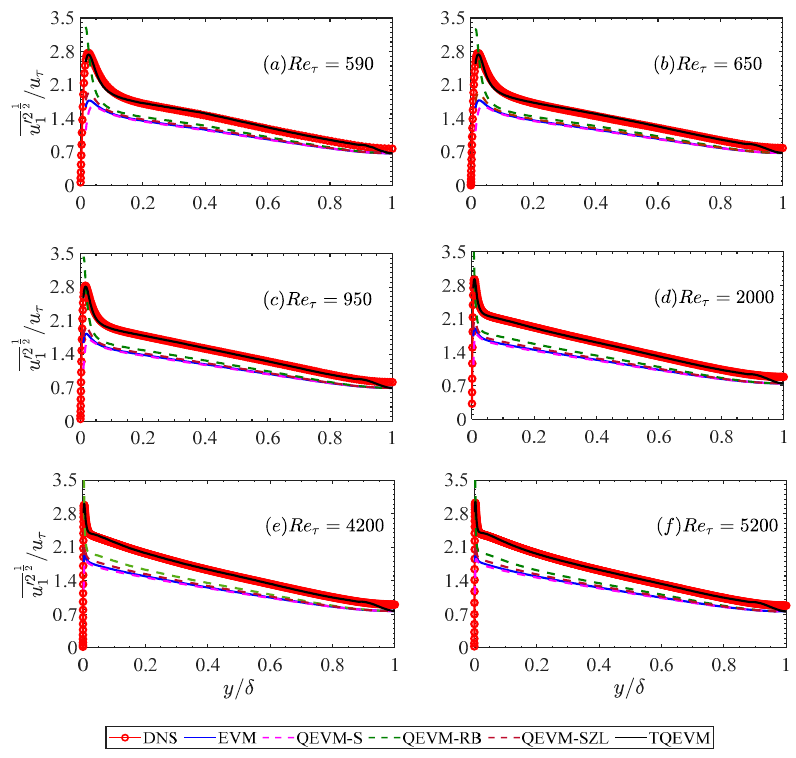
11/2 Figure 6. Dimensionless normal Reynolds stress (cid:1873) (cid:4593) (cid:2869)(cid:2870) (cid:3364)(cid:3364)(cid:3364)(cid:3364) (cid:2869) (cid:2870)⁄ (cid:1873) (cid:3099) (cid:3415) as a function of dimensionless wall distance (cid:1877) (cid:2012)⁄ Figure 6. Dimensionless normal Reynolds stress u (cid:48) 2 / u τ as a function of dimensionless wall distance for ( a ) (cid:1844)(cid:1857) (cid:3099) = 590 , ( b ) (cid:1844)(cid:1857) (cid:3099) = 650 , ( c ) (cid:1844)(cid:1857) (cid:3099) = 950 , ( d ) (cid:1844)(cid:1857) (cid:3099) = 2000 , ( e ) (cid:1844)(cid:1857) (cid:3099) = 4200 , and ( f ) (cid:1844)(cid:1857) (cid:3099) = 5200 Figure 6. Dimensionless normal Reynolds stress (cid:1873) (cid:4593) (cid:2869)(cid:2870) (cid:3364)(cid:3364)(cid:3364)(cid:3364) (cid:2869) (cid:2870)⁄ (cid:1873) (cid:3099) (cid:3415) as a function of dimensionless wall distance (cid:1877) (cid:2012)⁄ y / δ for ( a ) Re τ = 590, ( b ) Re τ = 650, ( c ) Re τ = 950, ( d ) Re τ = 2000, ( e ) Re τ = 4200, and ( f ) Re τ = 5200 for ( a ) (cid:1844)(cid:1857) (cid:3099) = 590 , ( b ) (cid:1844)(cid:1857) (cid:3099) = 650 , ( c ) (cid:1844)(cid:1857) (cid:3099) = 950 , ( d ) (cid:1844)(cid:1857) (cid:3099) = 2000 , ( e ) (cid:1844)(cid:1857) (cid:3099) = 4200 , and ( f ) (cid:1844)(cid:1857) (cid:3099) = 5200 obtained from DNS, EVM, QEVM-S, QEVM-RB, QEVM-SZL, and the proposed TQEVM. obtained from DNS, EVM, QEVM-S, QEVM-RB, QEVM-SZL, and the proposed TQEVM.